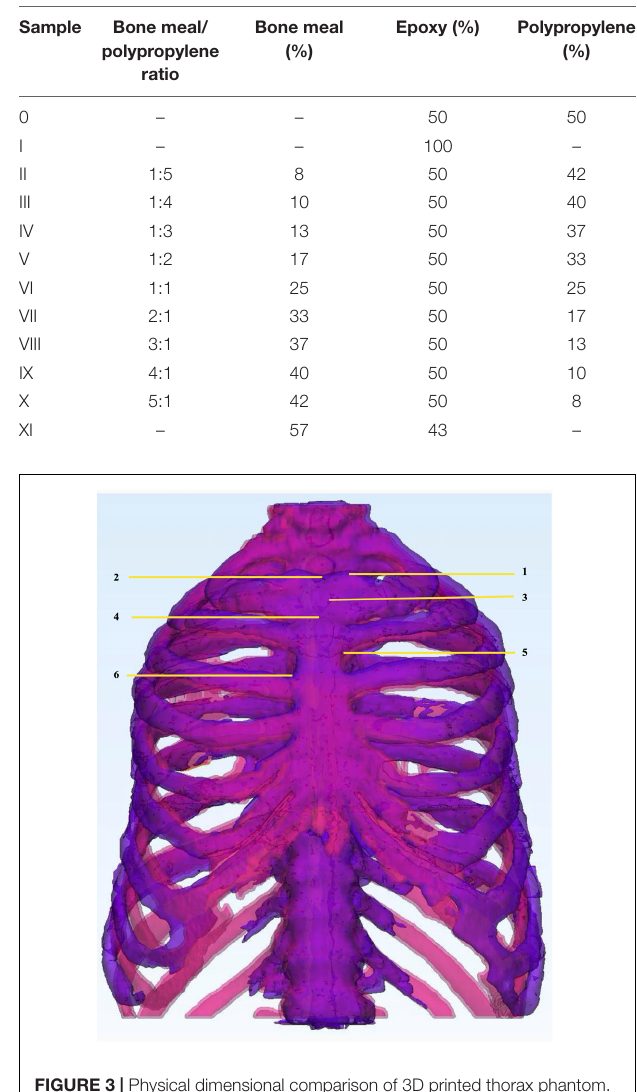
TABLE 1 | Different radiopaque amalgamate samples used in this study with their mixture ratios.